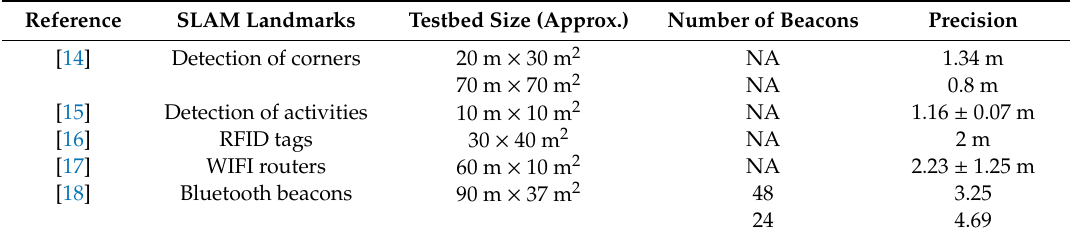
Table 1. Related